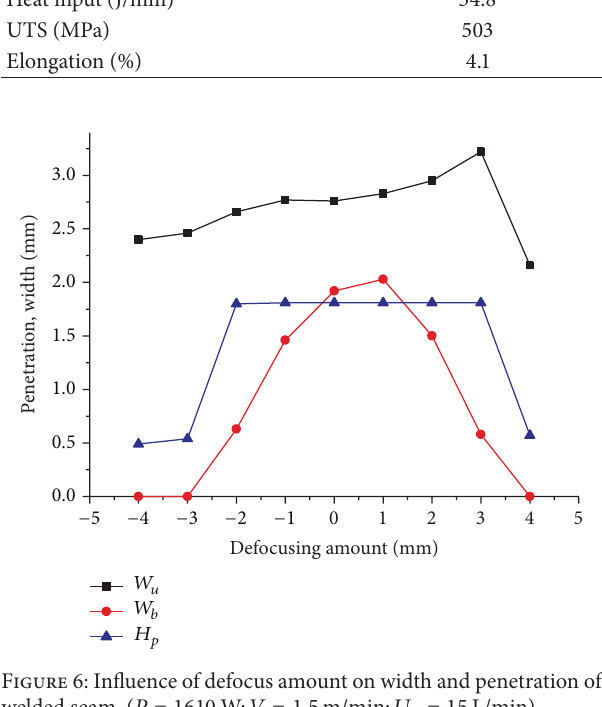
Figure 8: Influence of side-blow shielding gas flow rate on width and penetration of welded seam. ( 𝑃 = 1.5 kW; 𝑉 = 0.9 m/min; Δ𝑍 = 0 mm).